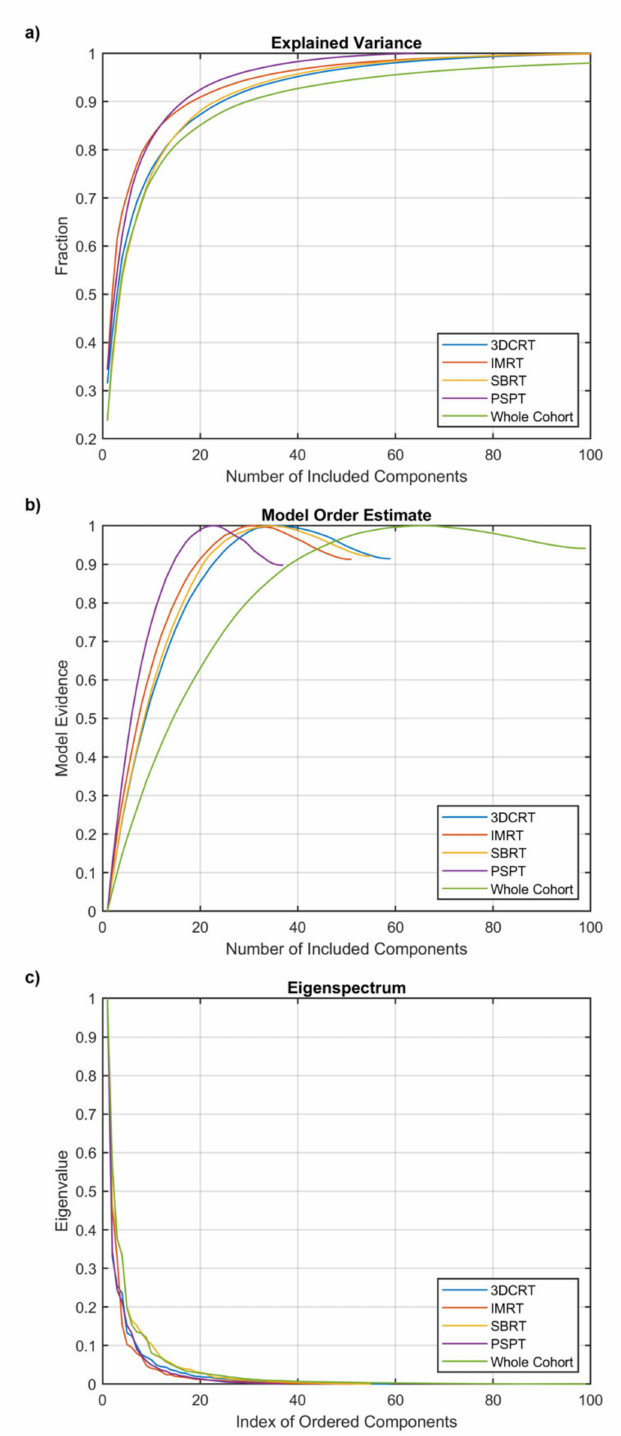
Figure 3. Probabilistic independent component analysis (PICA) order estimation for the analyzed groups of patients. ( a , b ) show the explained variance and the model evidence as a function of the included number of components; ( c ) shows the eigenvalue of each